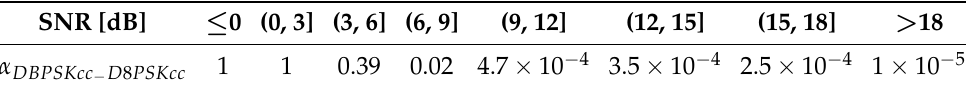
Table 1. α DBPSKcc conversion factors for 18-byte − D 8 PSKcc